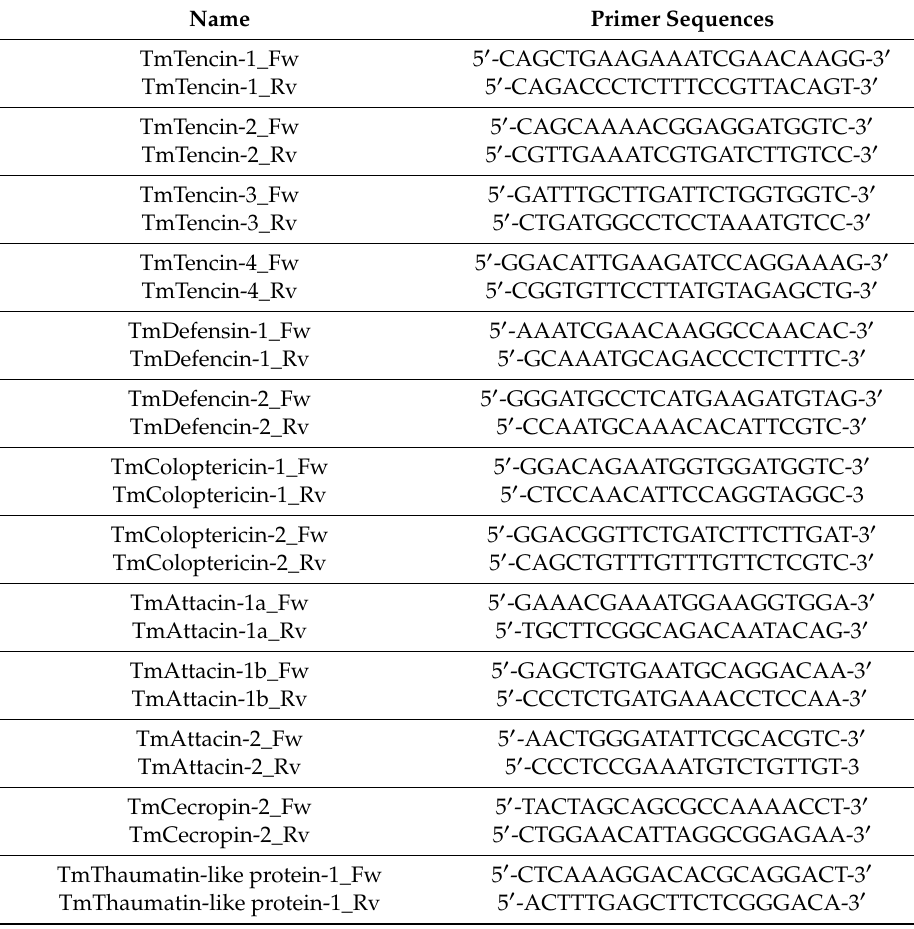
Table 2. Primers used in this